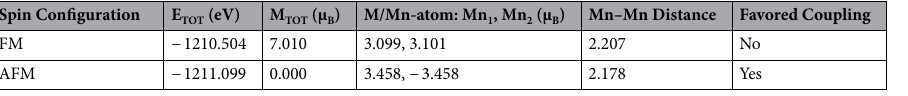
Table. 2. Total energy and magnetization and separate magnetic moments of Mn dimer embedded in C2N. Two spin configurations (FM and AFM) were tested.